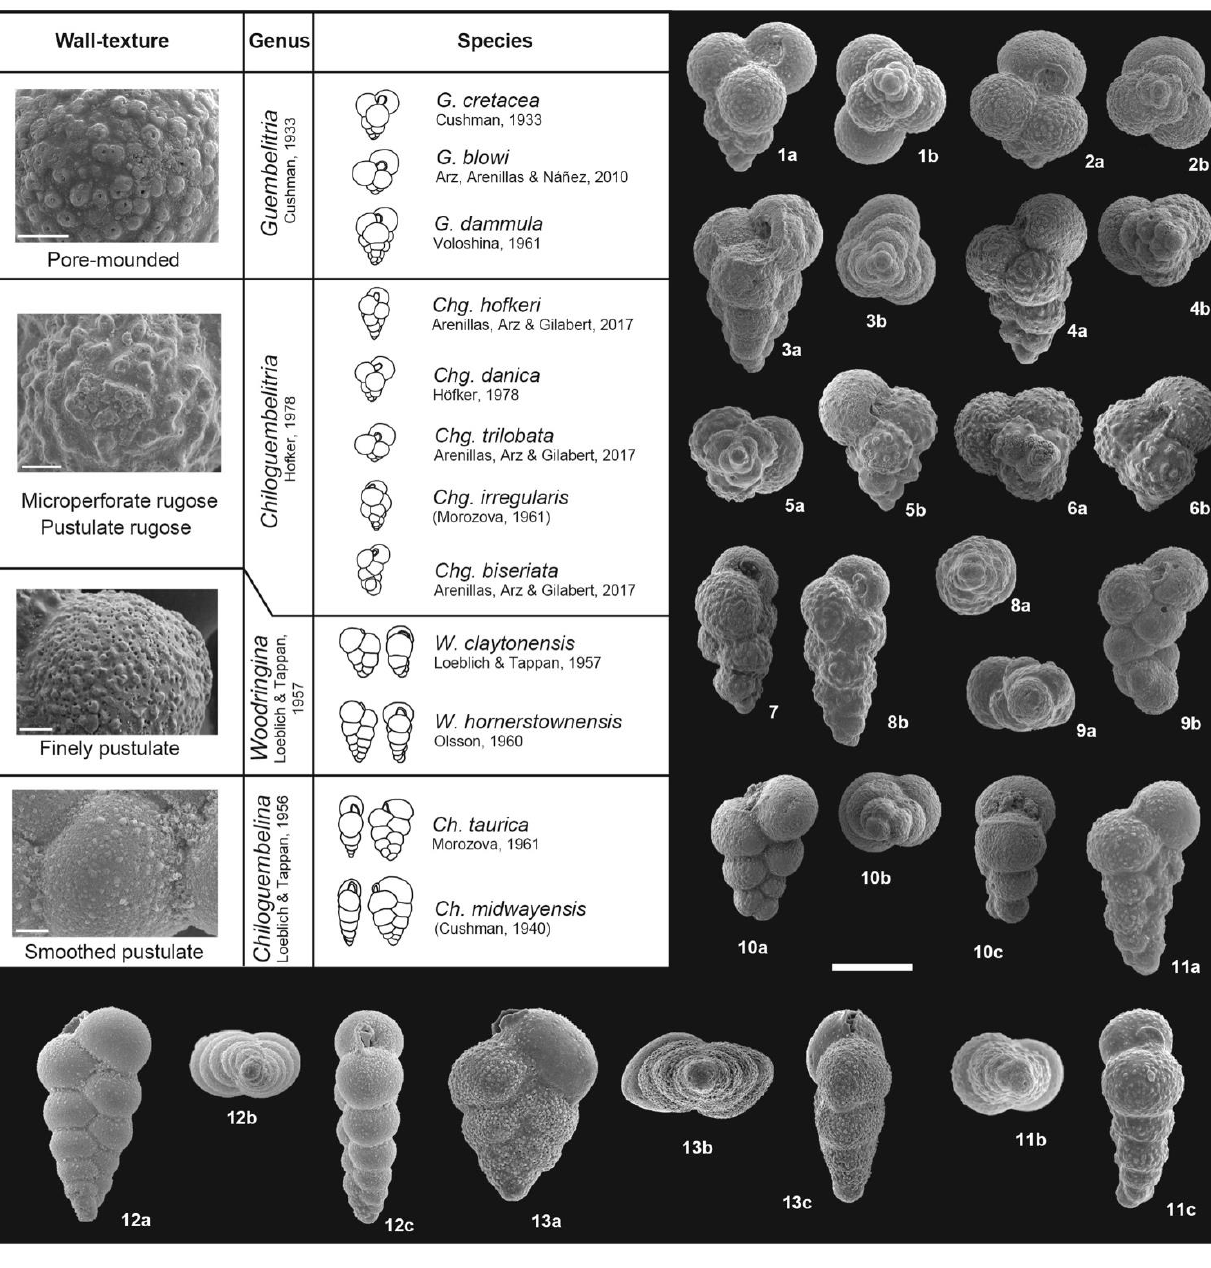
Figure A1. Species of Guembelitria, Chiloguembelitria, Woodringina, and Chiloguembelina . For taxonomic comparisons, the Maastrichtian species Guembelitria dammula is also included. 1. Guembelitria cretacea ; 2. G. blowi ; 3. G. dammula ; 4. Chiloguembelitria danica ; 5–6. Chg. irregularis ; 7. Chg. hofkeri ; 8. Chg. trilobata ; 9. Chg. biseriata ; 10. Woodringina claytonensis ; 11. W. hornerstownensis ; 12. Chiloguembelina taurica ; 13. Ch. midwayensis . See main diagnostic characters of these species and genera in Supplementary Text S1. All specimens are from El Kef, except those from Aïn Settara (10, 11), DSDP Site 305 (12), and Ben Gurion (13). Scale bar = 100 µ